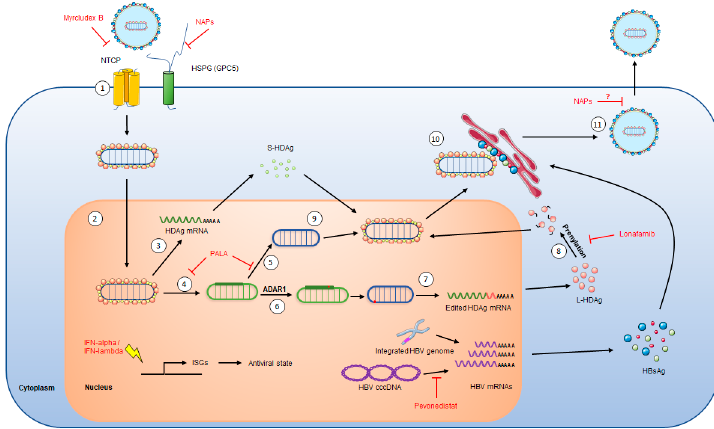
Figure 2. HDV life cycle. (1) HDV life cycle starts with HDV virions attachment to heparan sulfate proteoglycans (HSPG), including Glypican 5 (GPC5), at the hepatocyte surface. L-HBsAg pre-S1 region then binds to HBV/HDV specific receptor, the bile acid transporter NTCP. Viral particle enters the cell through endocytosis and viral RNP is freed in the cytoplasm. (2) Both forms of HDAg contain a nuclear localization signal that induces viral RNP translocation to the nucleus. (3) In the nucleus, HDAg mRNA transcription is done by RNA polymerase II. HDAg mRNA is then exported in the cytoplasm where it is translated to produce the small form of HDAg (S-HDAg). (4) During the first step of replication, HDV genomic RNA serves as a template for antigenomic RNA production, probably done by RNA polymerase I. (5) Antigenomic RNA is recognized by RNA polymerase II to produce new genomic RNAs. (6) Antigenomic RNA is edited by ADAR1 enzyme, suppressing S-HDAg stop codon. (7) Edited antigenomic RNA is replicated into genomic RNA, then inducing the transcription of edited HDAg mRNA that is exported in the cytoplasm where it leads to the production of the large form of HDAg (L-HDAg). (8) L-HDAg contains a prenylation site that is farnesylated by a cellular farnesyltransferase before being translocated to the nucleus. (9) Both forms of HDAg interact with newly synthesized genomic RNA to form new viral ribonucleoproteins (RNP) that are exported to the cytoplasm. (10) Viral RNPs interact, through their farnesylated cystein in L-HDAg, with the cytosolic part of HBsAg at the endoplasmic reticulum surface, thus inducing their envelopment. (11) HDV virions are then secreted form the infected cell. The different steps targeted by antiviral treatments are indicated. Represented cell is also infected by HBV, indicated by its cccDNA or its integrated genome, but its life cycle is not depicted.